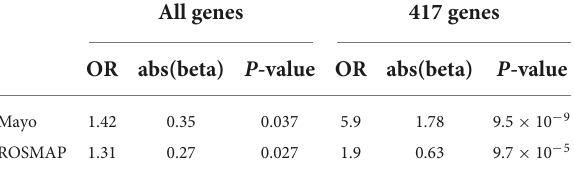
All genes 417 genes OR abs(beta) P -value OR abs(beta) P -value